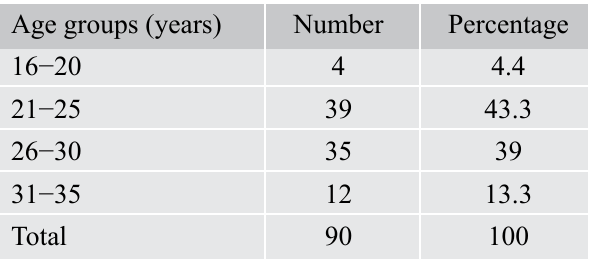
Table III: Distribution of perinatal diagnosis of SGA